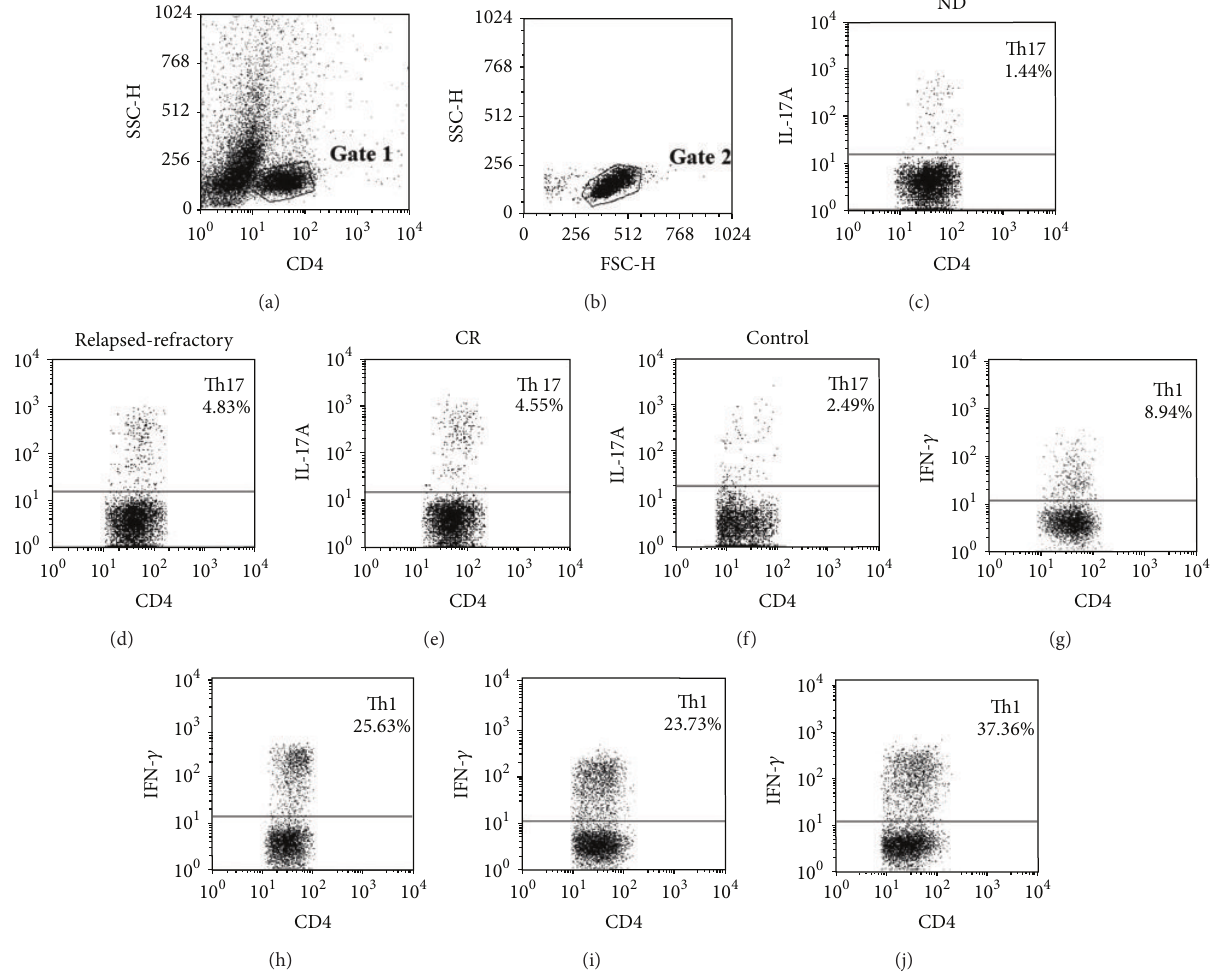
Figure 1: BM Th17 and Th1 cells in representative patients with ND, CR, and relapsed-refractory AML and controls. (a) 5000 CD 4 + cells were collected by flow cytometry. (b) CD 4 + lymphocytes were gated. (c), (d), (e), and (f) The percentages of BM Th17 (CD 4 + IL-17 + ) cells in ND, CR, and relapsed-refractory AML patients and controls. (g), (h), (i), and (j) The percentages of BM Th1 (CD 4 + IFN- 𝛾 + ) cells in ND, CR, and relapsed-refractory AML patients and